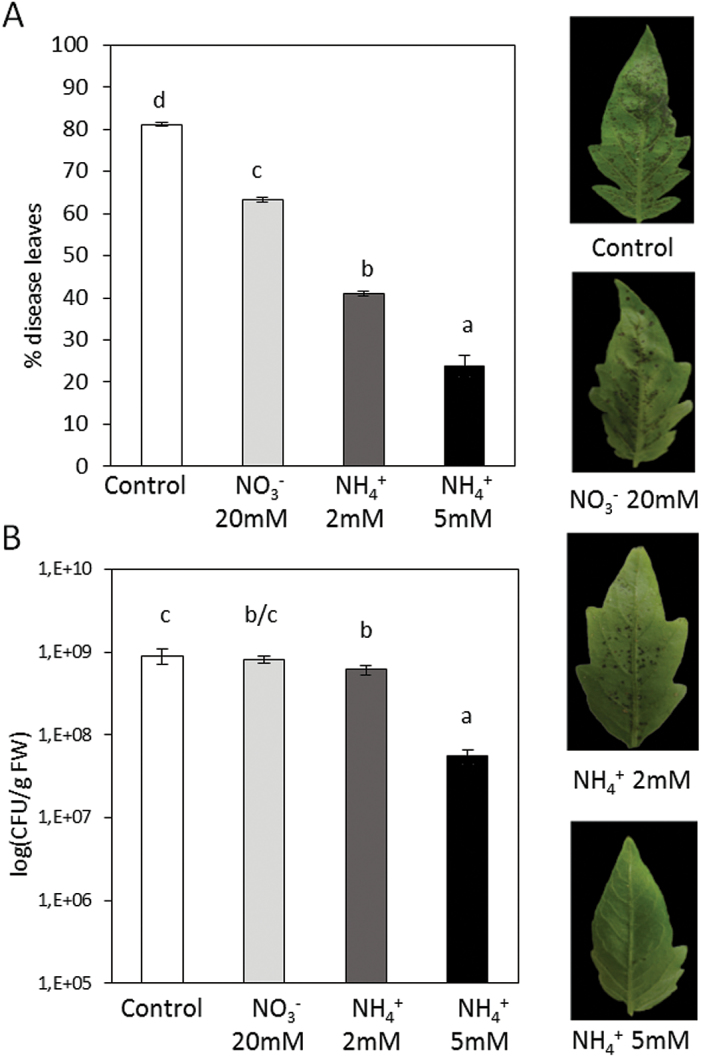
Effect of different N treatments on the resistance of tomato plants to Pst. Four-week-old tomato plants grown with different NO3
– and NH4
+ concentrations were inoculated by dipping them in a bacterial suspension of Pst at 5×105 cfu ml−1. At 72 hpi, the disease rating was scored by measuring the percentage of infected leaves in relation to the total number of analysed leaves (A) and by recounting of bacterial populations by plating in agar–KB medium (B). The photograph shows a representative picture of disease symptoms in the different N treatments. Data show the average of three independent experiments of a pool of 10 plants per experiment ±SE. Letters indicate statistically significant differences (P<0.05; least-significant difference test). (This figure is available in colour at JXB online.)